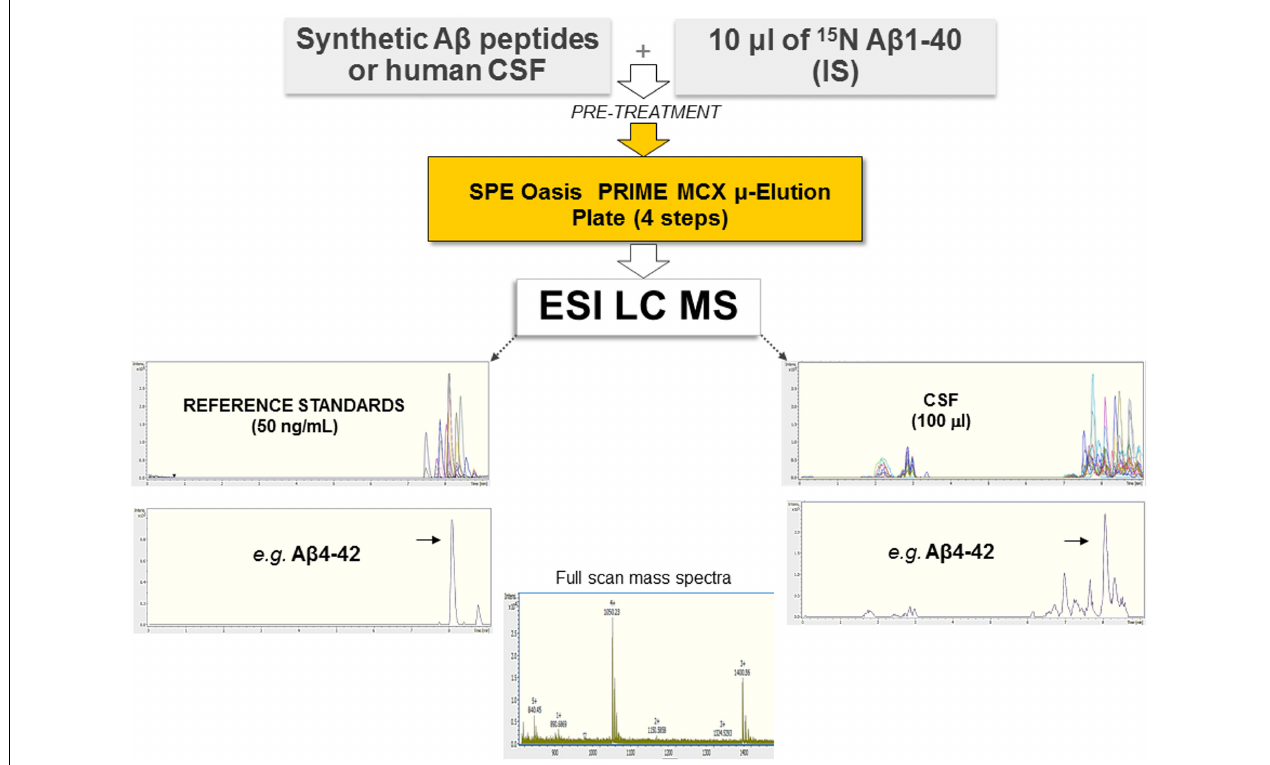
FIGURE 1 | Schematic representation of the method employed, based on SPE and ESI-LC-MS. Synthetic A β peptides or hCSF and the isotopically labeled IS were diluted with 5 M GuHCl, shaken at room temperature for 45 min, and then further diluted with 4% H 3 PO 4 in H 2 O (pre-treatment). Each sample was extracted using a µ -elution mixed-mode cation exchange SPE method. Samples were analyzed using a UHPLC–MS system consisting of a Bruker compact QqTOF mass spectrometer and a Thermo Scientific Dionex UltiMate 3000 Rapid Separation LC equipped with an Acquity UPLC BEH C18 column. Representative spectra of all A β peptides as well as of A β 4–42 are shown.